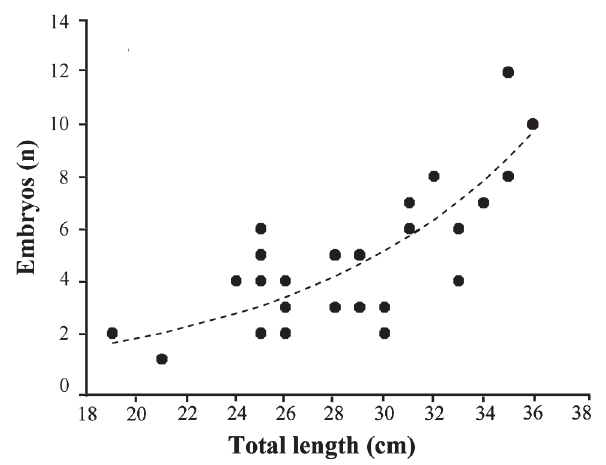
Fig. 9. Relationship between total length of the female (TL) and number of embryos (N line)= 0.221 X exp (0.589 X TL) ; R²= 0.57; n=